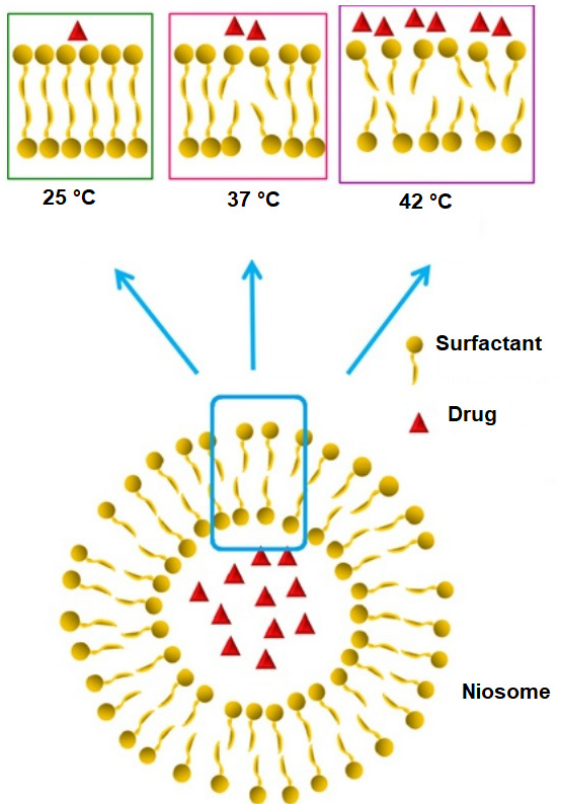
Figure 5. Schematic representation of temperature effect on payload release from thermoresponsive niosomes. (Reproduced from [105] with permission from Elsevier, Amsterdam, 2022.).